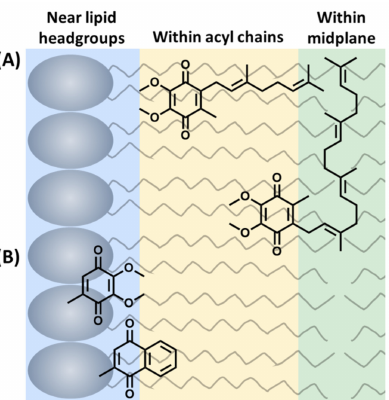
Figure 3. Three possible locations of the lipoquinone headgroup: ( A ) Example of the influence of sidechain on the location of the headgroup. UQ-2 and UQ-4 are both shown as illustrative examples within the acyl chains or within the midplane. ( B ) Example of the influence of headgroup polarity on the location of the quinone headgroup in the membrane (sidechains omitted for clarity). This figure was originally published in Ref. [41] to include UQ-derivatives in ( A ). It is licensed under CC-BY